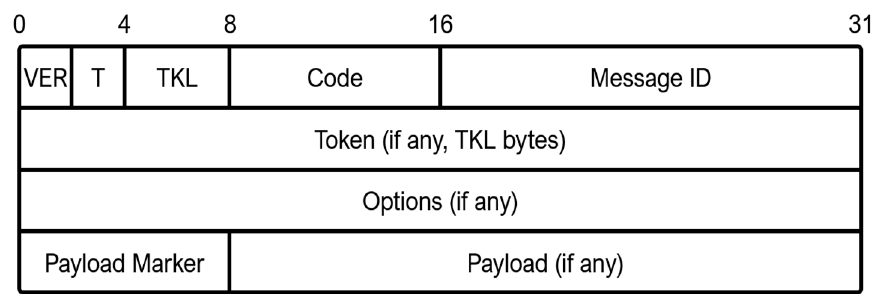
Figure 1. CoAP over UDP header format.